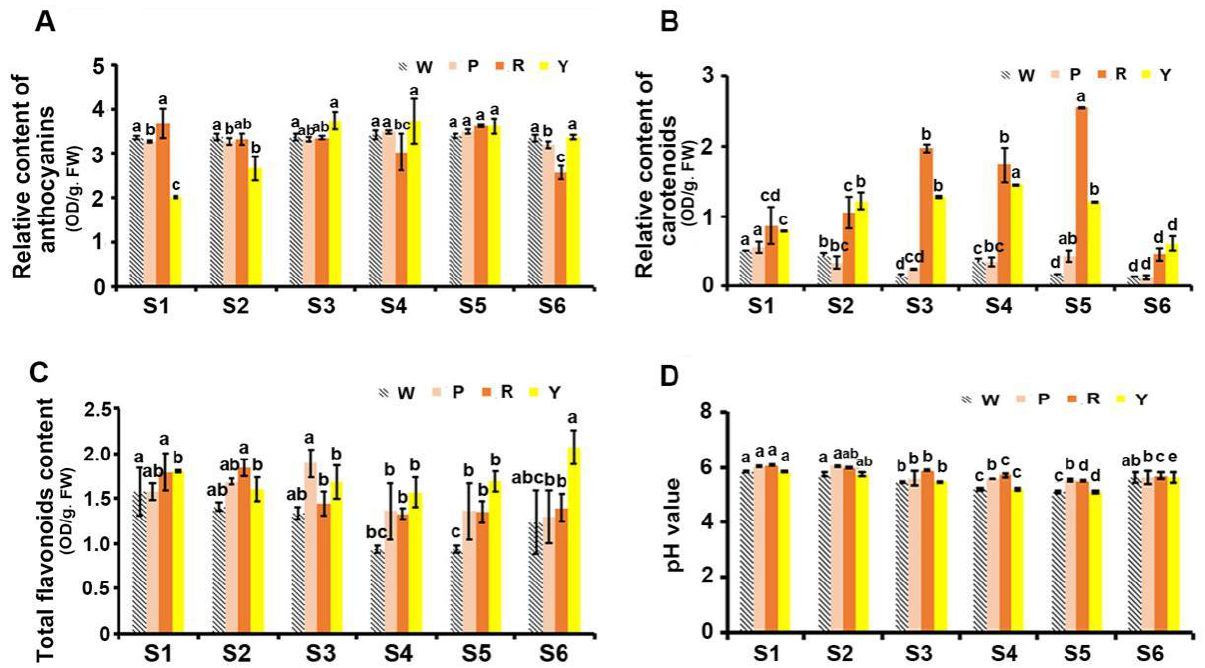
Figure 3. The pigment content and pH value of ray florets of four colored chrysanthemums. The relative content of total anthocyanins ( A ), carotenoids ( B ), and total flavonoids ( C ) of ray florets of four colored chrysanthemums at six flowering stages. ( D ) The cytosol pH value of ray florets of four colored chrysanthemums at six flowering stages. Data are shown as the mean ± standard error of the mean, based on more than five replicates. Different letters indicate significant differences at p < 0.05 according to the Duncan’s multiple range test.